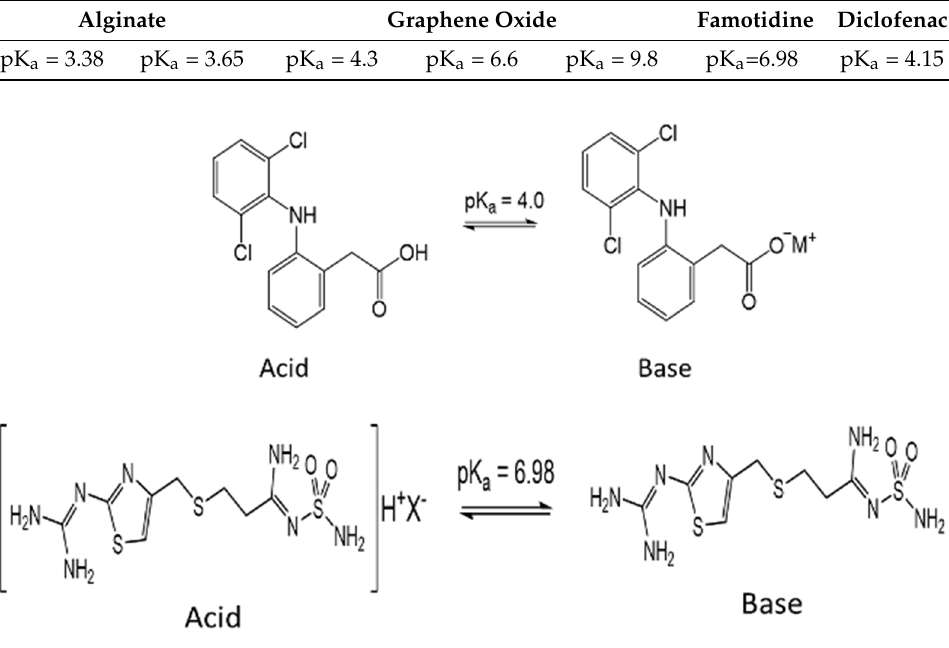
Figure A7. GO displayed a strong D band at 1357 cm − 1 . Raman spectra can be deconvoluted (inset spectrum) to three Lorentzian peaks (with adj. R-Squared ≥ 92%). D/IG is 1.27 for GO.